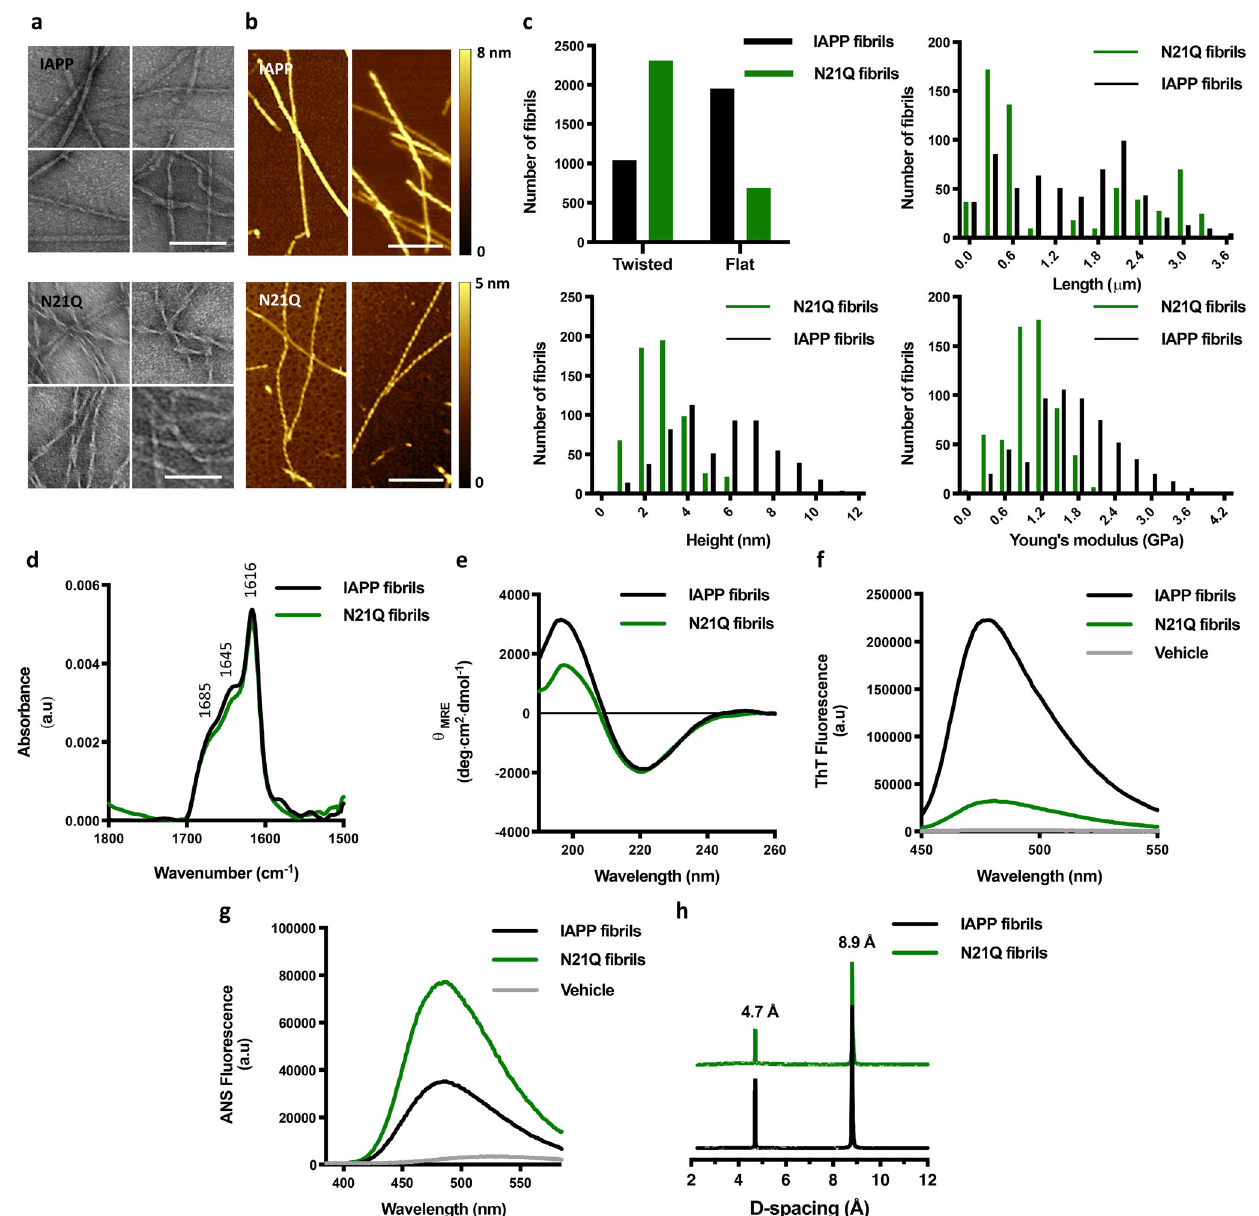
Fig. 2 Characterization of N21Q cytotoxic fi brils. a , b Representative images of fl at and twisted IAPP and N21Q fi brils revealed by a TEM and b AFM. Scale bar: 100 nm. c Distributions of mesoscopic morphology and stiffness of over 3000 fi brils per peptide imaged by AFM. d ATR-FTIR absorbance spectra of the amide I region (1500 – 1800 cm − 1 ) of IAPP and N21Q fi brils. e Far-UV circular dichroism spectra of IAPP and N21Q fi brils. f ThT fl uorescence of fi